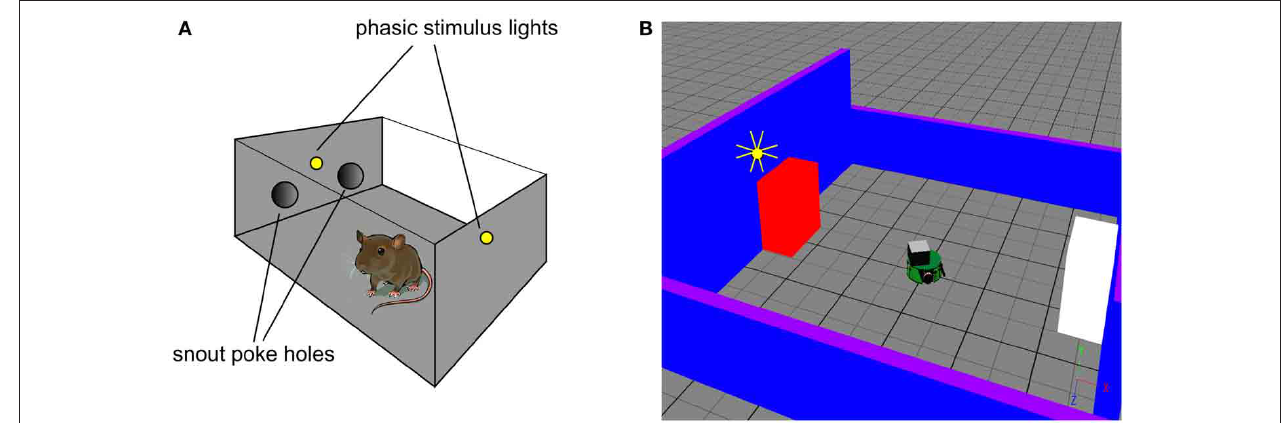
FIGURE 2 | In vivo experimental paradigm of Gancarz et al. (2011) (panel A) and our embodied in silico counterpart (panel B). (A) Shows the small test chamber used with rats undergoing instrumental learning. One side of the chamber has two poke holes with a light above them. Rat snout entry into the “active” poke hole may cause the two lights to flash and the active hole may be either one (for